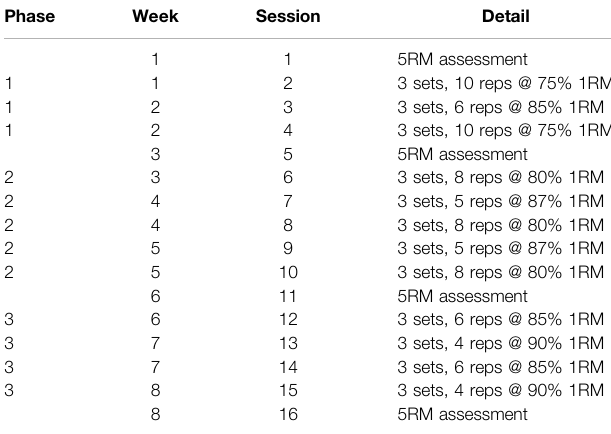
TABLE 1 | Details of the 8 weeks resistance training